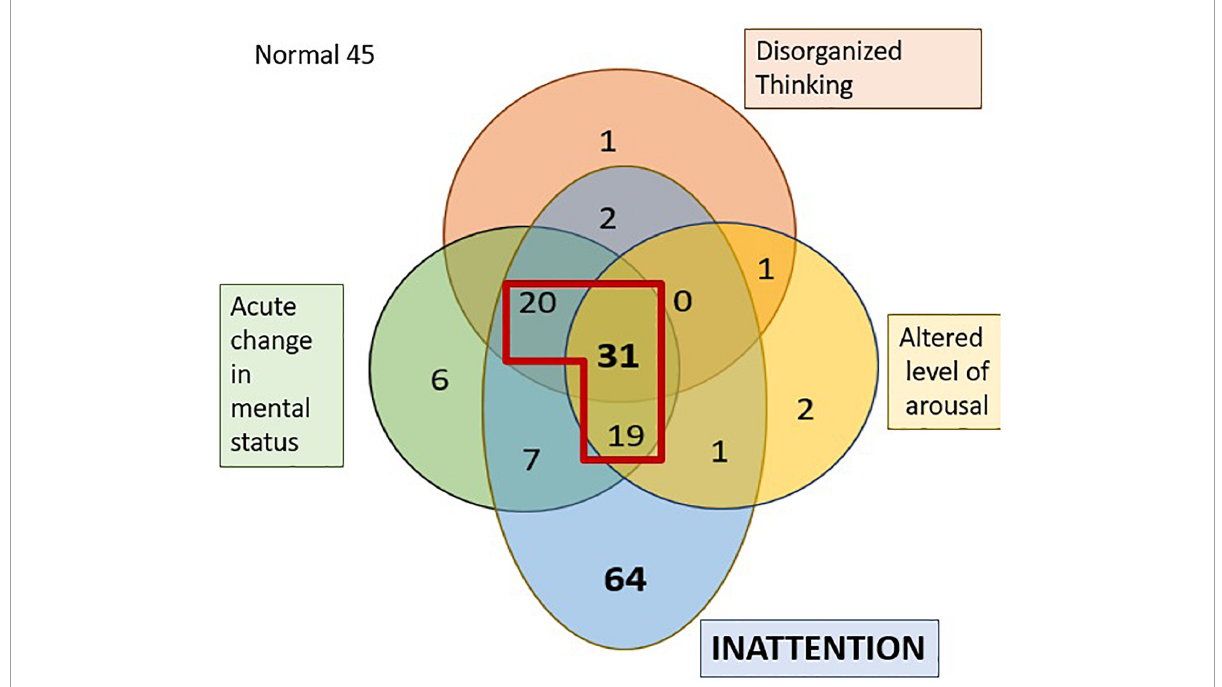
FIGURE1 Venn diagram representing the distribution of the four features of delirium in the PACU. The numbers represent the individuals who failed the tests of that specific domain. The section in diagram within the red outline is those diagnosed as having delirium as per the 3D-CAM. 45 individuals had no features of delirium.